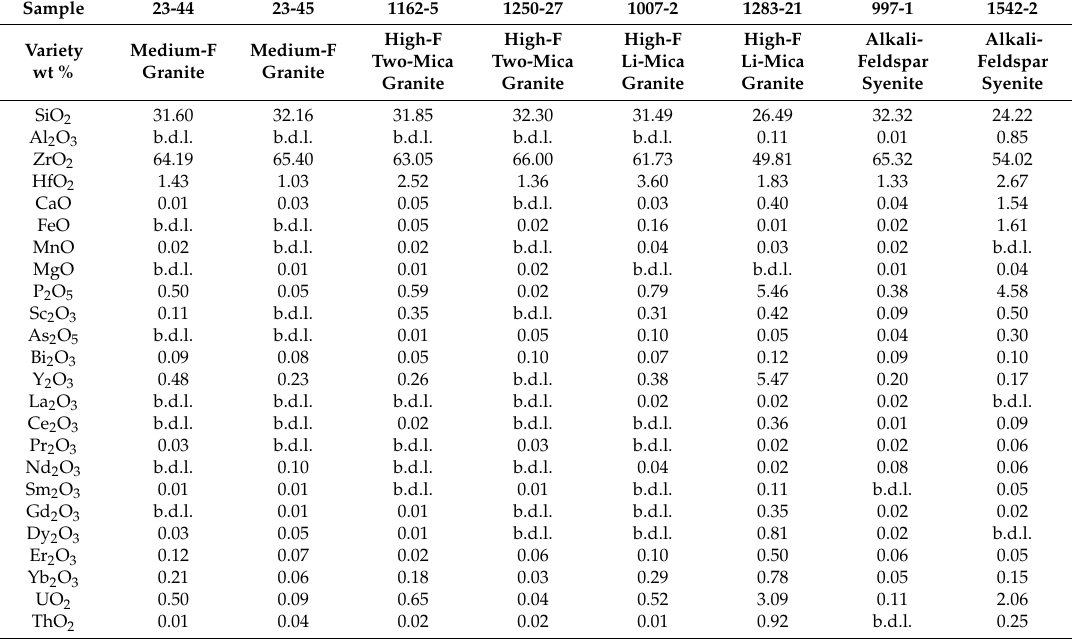
Table 4. Representative EPMA of zircon.